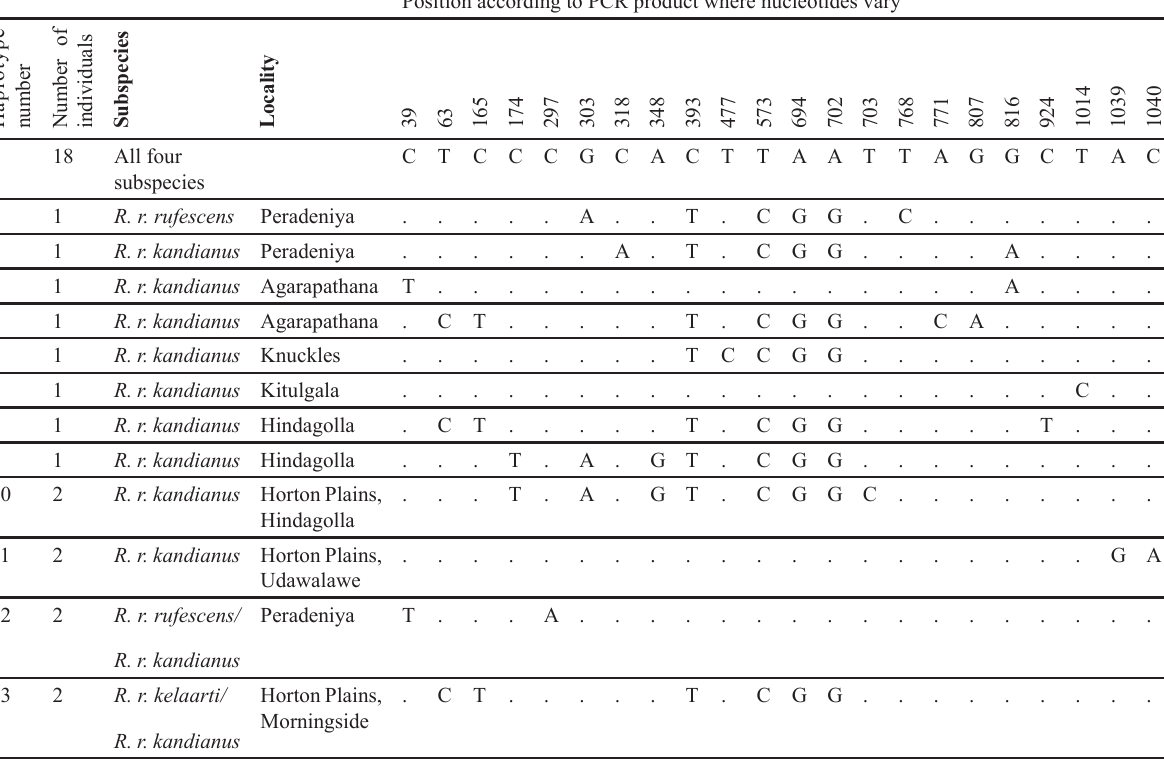
Table 2: The cytochrome-b haplotypes of the sub-lineage RrC LIb ( Rattus rattus Complex: Lineage I b), number of individuals found with each haplotype, their subspecies representation, localities and single-nucleotide polymorphism (SNPs)/ insertions and deletions (INDELs) compared with common haplotype 1. Position according to PCR product where nucleotides vary